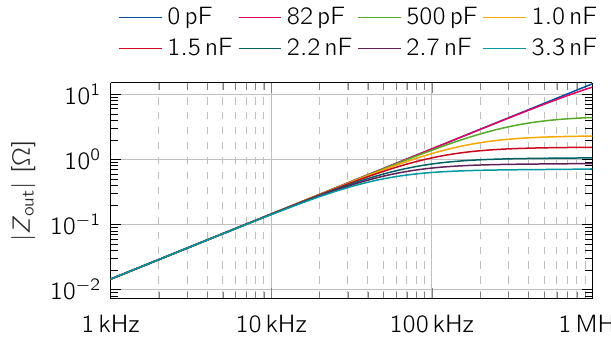
Figure 8: Simulative output impedance of the symmetrical VS for various C v